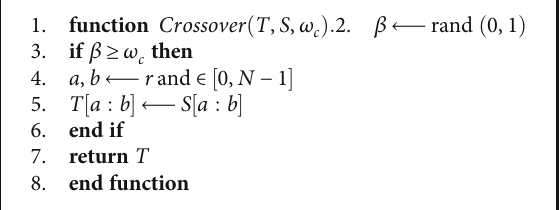
Algorithm 1. The crossover